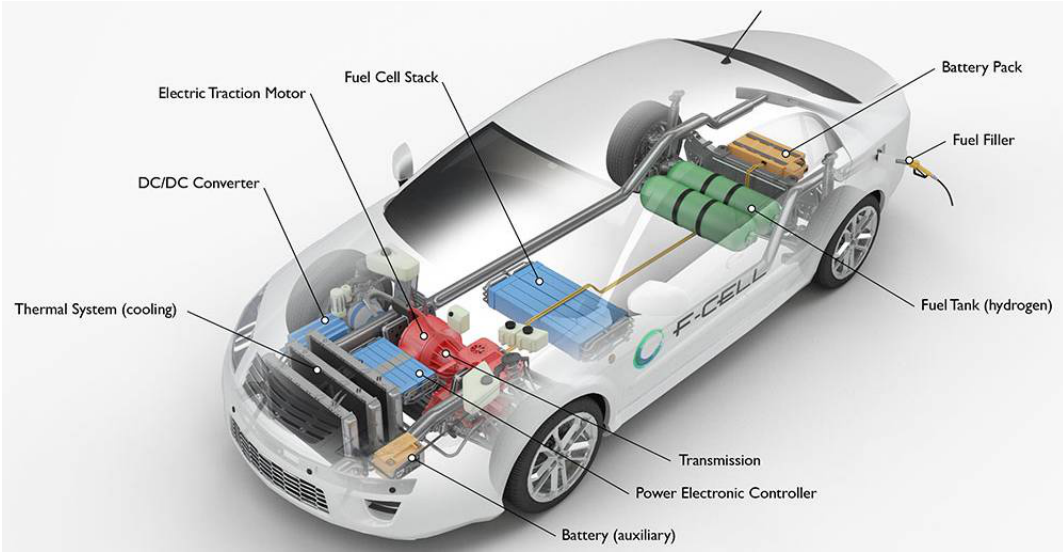
Figure 20. Diagram of a Fuel Cell Electric Vehicle (FCEV) and its main components.